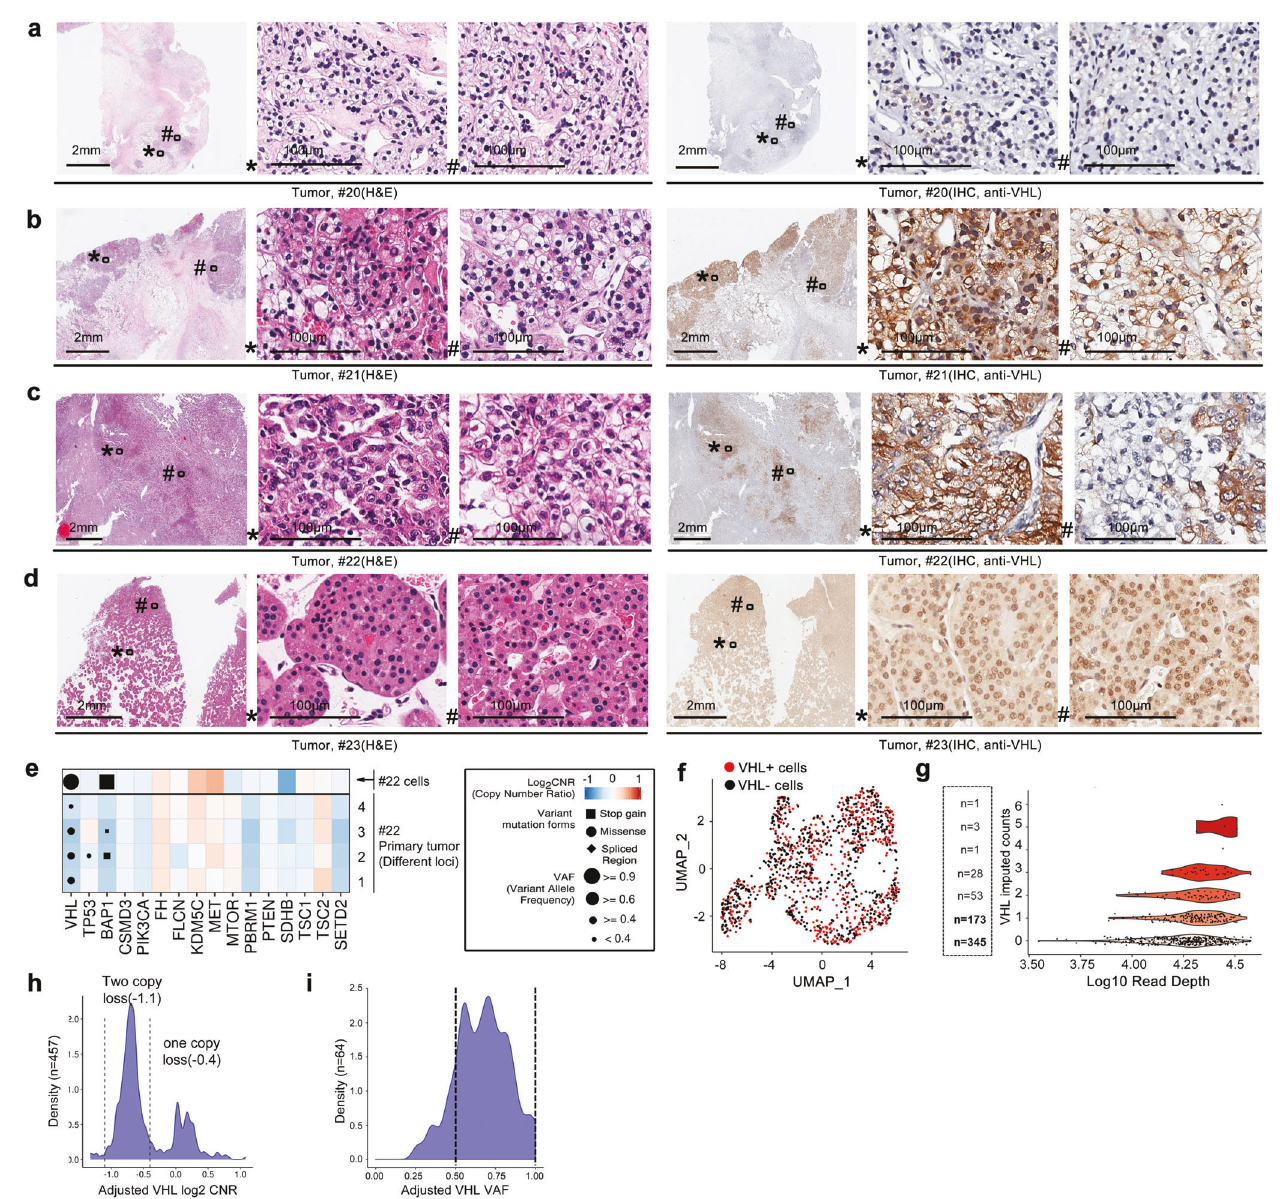
Fig. 1 Human ccRCC tumor specimen showed intratumoral heterogeneity in VHL expression. H&E stain and VHL IHC performed on parallel sections of tumor from different cases of human RCC are shown in ( a ) case #20, ( b ) case #21, ( c ) case #22 and ( d ) case #23. Scale bar for low magni fi cation fi eld: 2 mm; for high magni fi cation fi eld: 100 μ m. e Mutational data from WES of common oncogenic driver genes in ccRCC are shown for four loci of the patient ’ s tumor and the derived cell line of case #22. Point sizes represent variant allele frequencies. Values above 0.4 represent likely clonal mutations and above 0.9 represent clonal mutations combined with loss of heterozygosity. Colors represent log2 CNRs for each gene, with DNA gains in red and losses in blue. f UMAP dimensionality reduction plot of single-cell sequencing from the case #22 primary tumor tissue and disassociated primary tumor cells colored by VHL expression positivity in each cell. A total of 1343 P0 (passage 0) #22 tumor cells were analyzed. g Scatterplot of sequencing depth vs. VHL imputed gene expression across non-cycling single cells from single cell sequencing in the case #22 with the number of cells at each expression level of VHL listed. h Density plot showing the CNRs of the VHL locus in the TCGA-KIRC cohort ( n = 459) after adjusting for both tumor purity and ploidy with consensus estimates of purity. A CNR value of − 1.1 represents a two-copy loss of VHL (dotted line) and − 0.4 indicates one copy loss. i Density plot showing the VAF of somatic VHL mutations in the TCGA-KIRC cohort ( n = 148) after adjusting for both tumor purity and ploidy (with consensus estimates of tumor